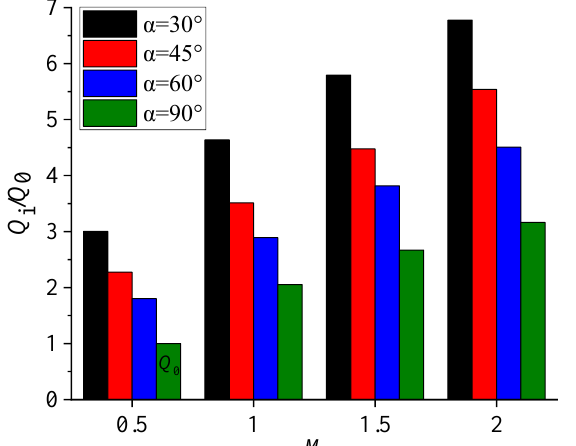
Figure 12. Relative heat transfer quantity on the internal surface of film holes with different values of α. The area-averaged φ is presented in Figure 13. The results showed that the cooling system with α = 30 ◦ provided the highest area-averaged φ at all values of M . The area-averaged φ for cases with different inclination angles also increased with an increasing M